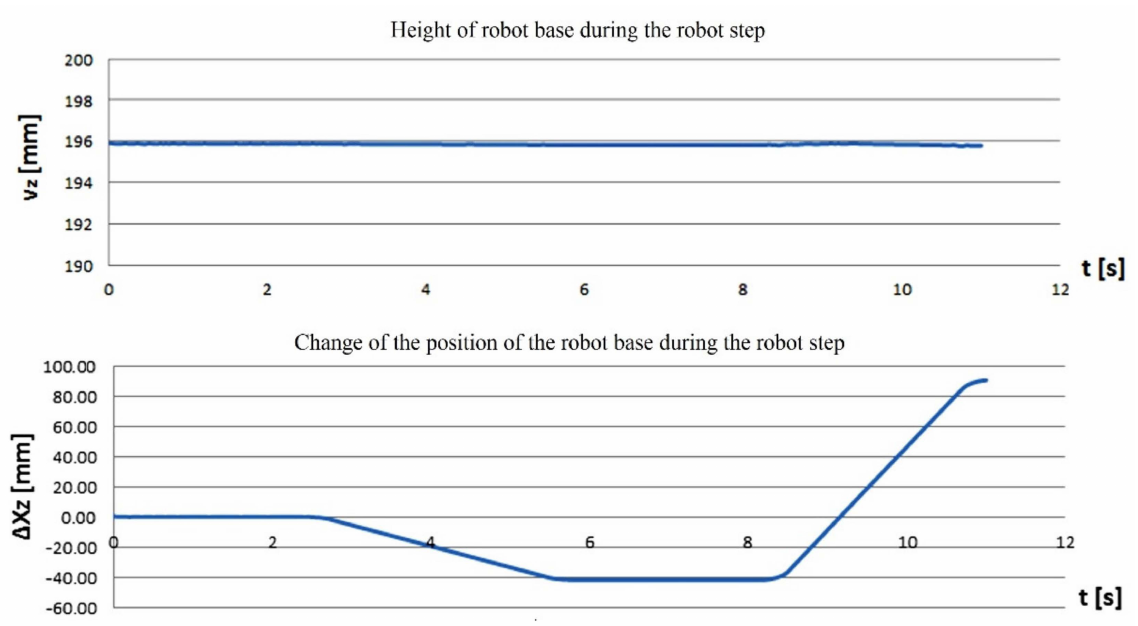
Figure 15. Graph of the robot’s center of gravity position during the step. The changes in position of the robot’s base during the step are shown in Figure 16.